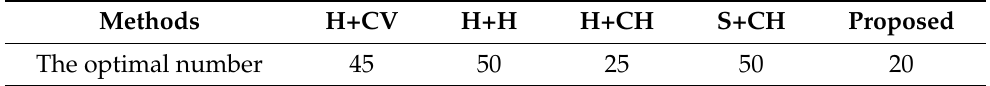
Table 2. The optimal number of clusters for each method in color features.